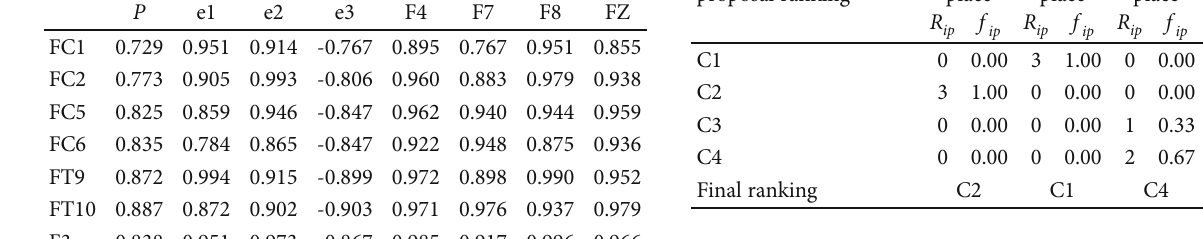
Table 7: Frequency table of EEG test evaluation.